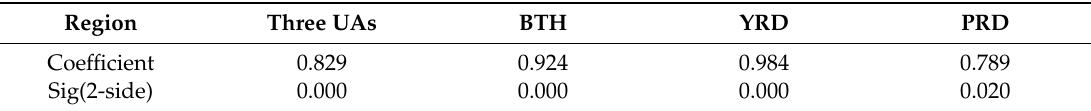
Table 5. The Pearson coefficient between urban comprehensive attractiveness for migrants (UAM) and external-MAI.